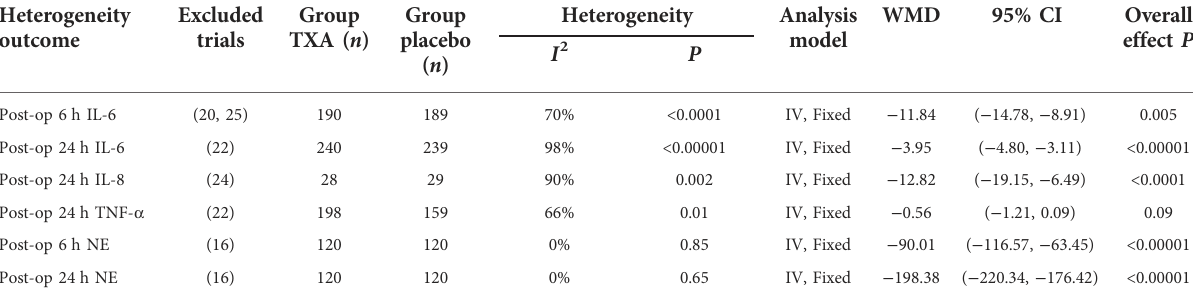
TABLE 5 Sensitivity analyses of high-heterogeneity outcomes.